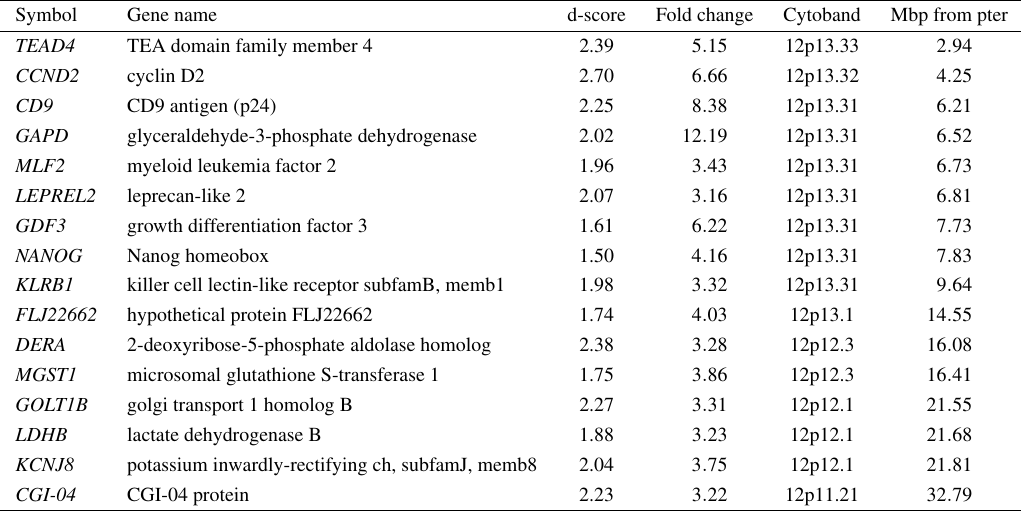
Significantly overexpressed genes on chromosome arm